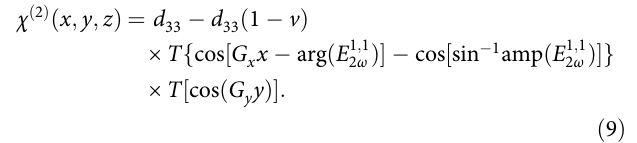
NPC (Fig. 1b) fabricated by the femtosecond-laser-erasing